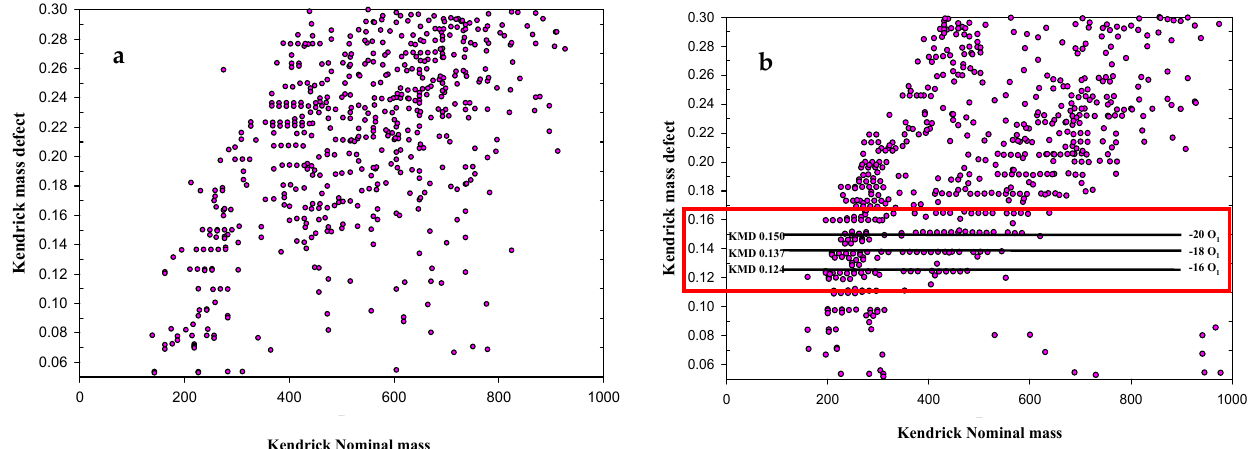
Figure 7. Kendrick mass plots of the O 1 -O 10 species found in the untreated crude oil WSF ( a ) and the 1-h photocatalysed sample ( b ).